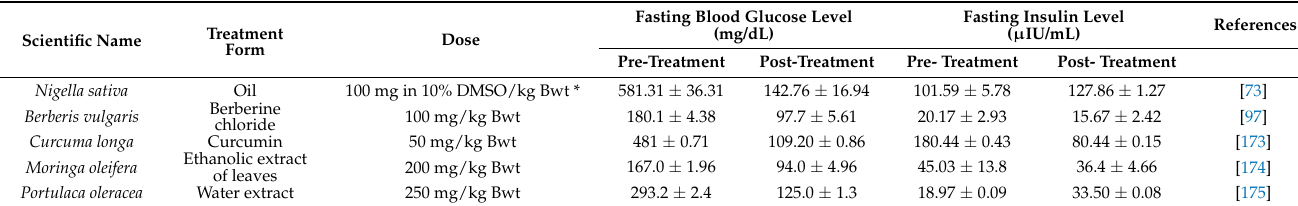
Table 2. Previous in vivo studies on the effect of medicinal plants on